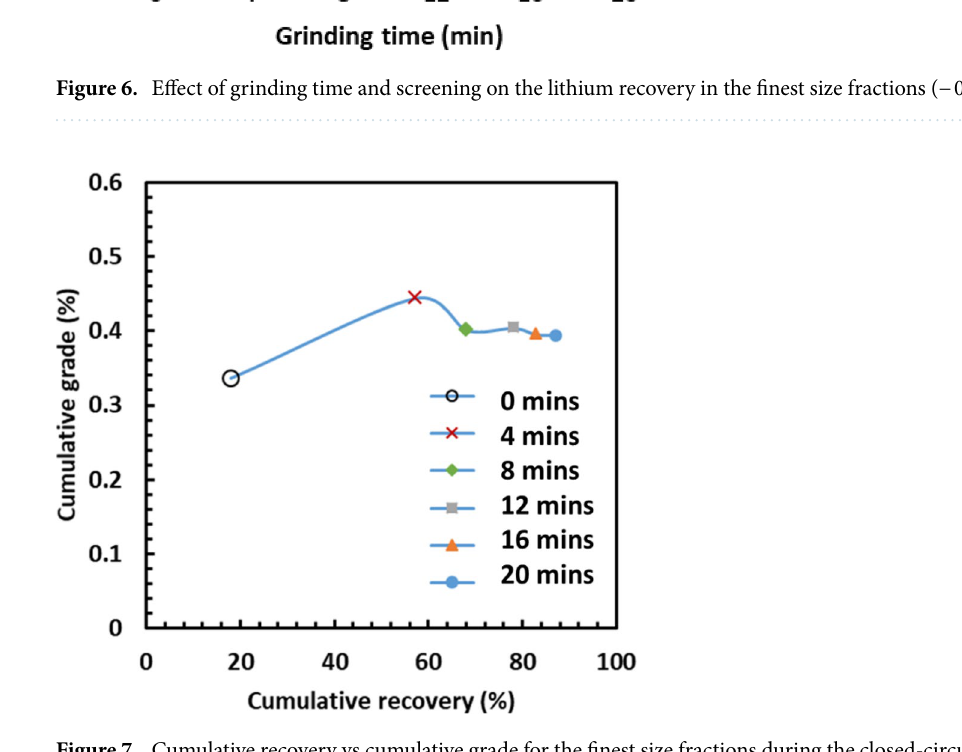
Figure 7. Cumulative recovery vs cumulative grade for the finest size fractions during the closed-circuit grinding.